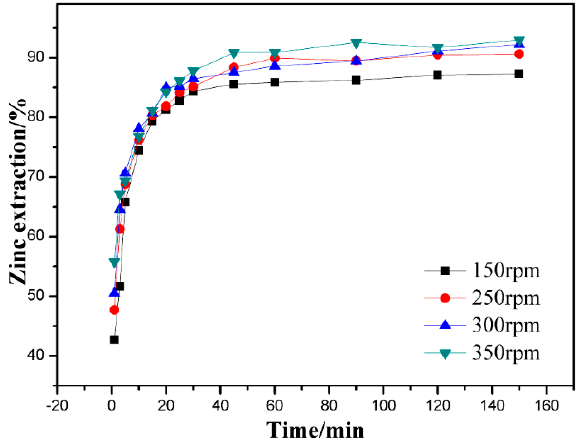
Figure 4. Effect of stirring speed on zinc extraction (5.0 mol/L NH 4 Cl; solid/liquid ratio, 5 g/L; temperature, 95 °C; and particle size, 45–61 μ m).